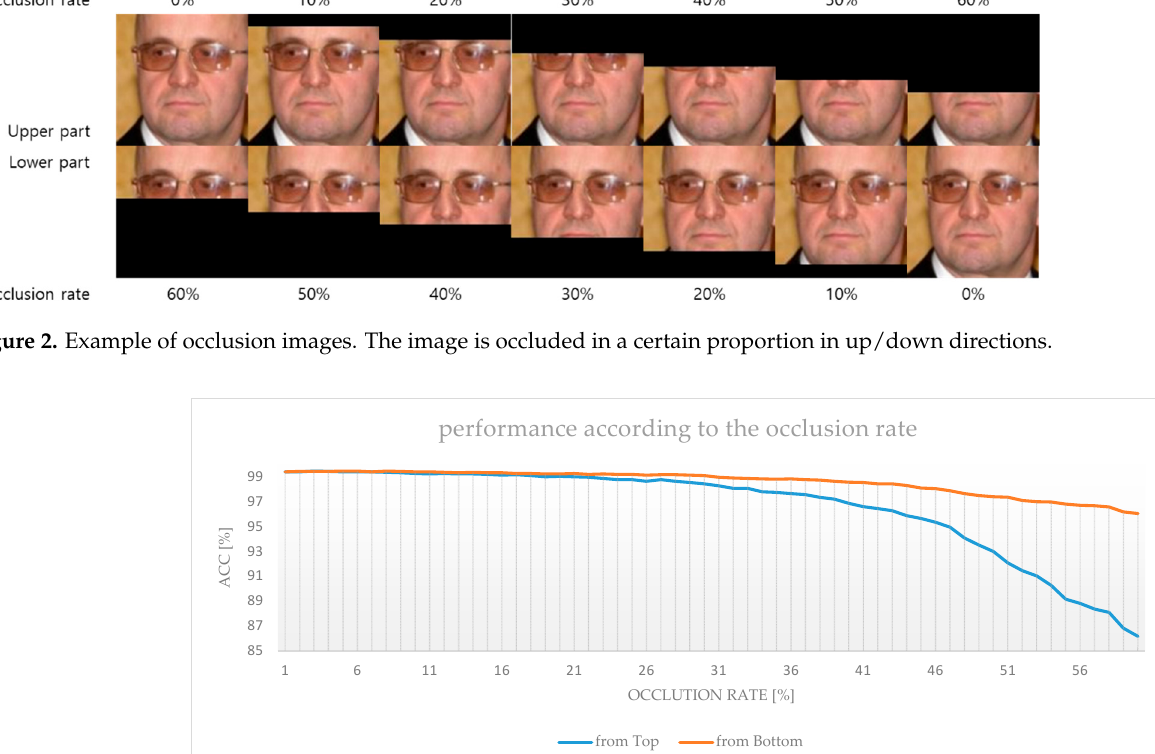
Figure 2. Example of occlusion images. The image is occluded in a certain proportion in up/down directions.